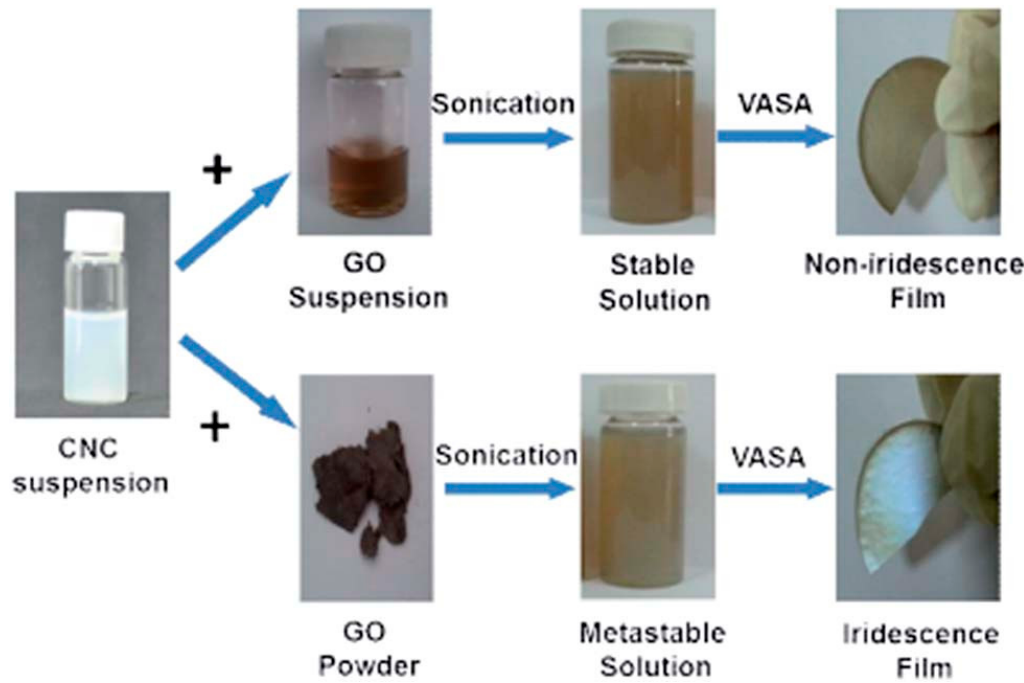
Figure 7. Schematic illustration of the preparation process of GO / CNC hybrid films with or without iridescence. Reproduced with permission from Reference [151]. Copyright © 2014, The Royal Society of Chemistry.